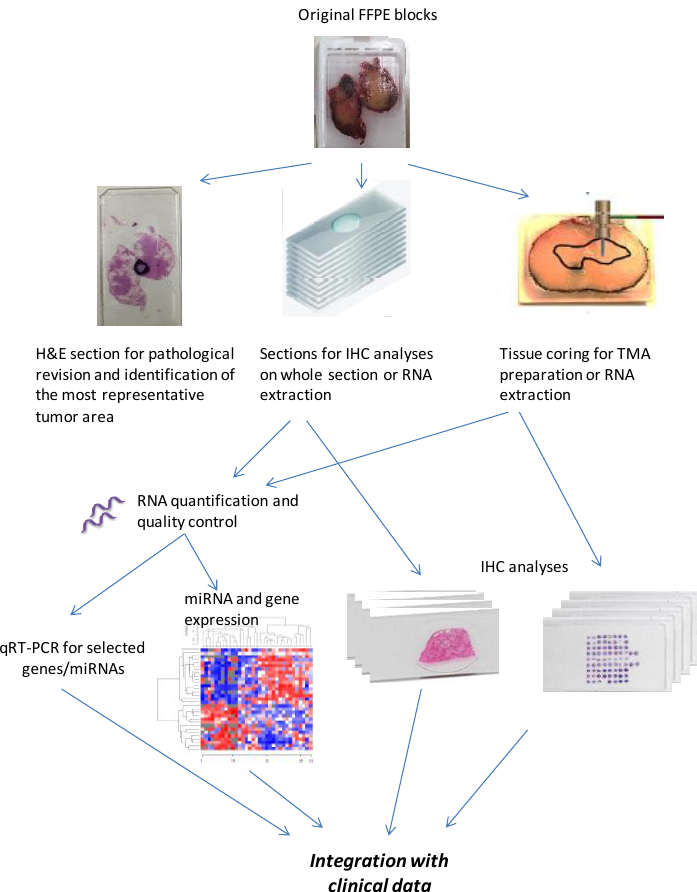
Figure 1. Schematic representation of formalin-fixed, paraffin-embedded (FFPE) block processing for translational analyses associated with the Multicenter Italian Trial in Ovarian Cancer (MITO) clinical trials.